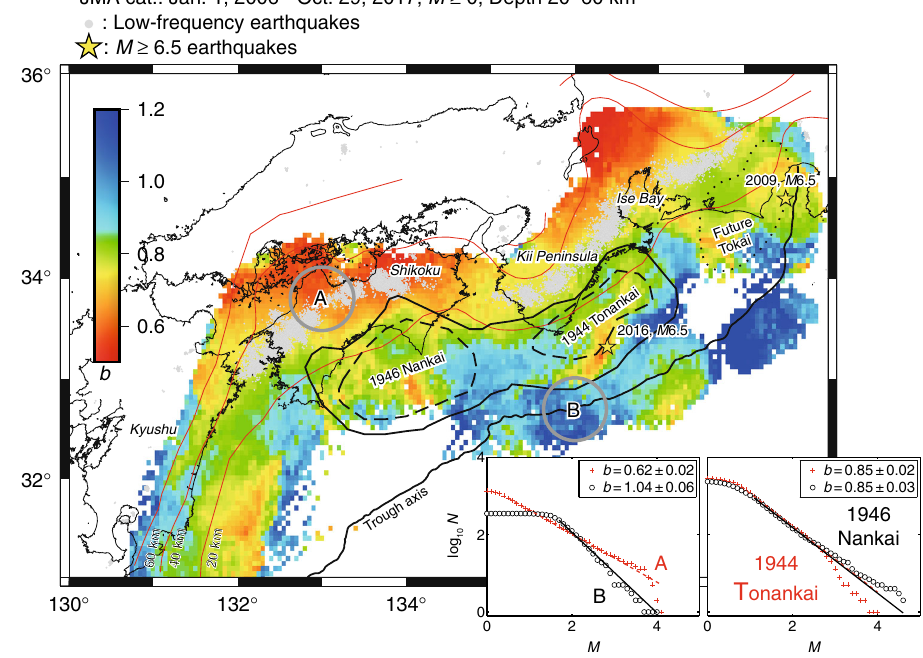
Fig. 1 Map of b values. Earthquake data used to create this b map are given at the top left of this fi gure (also see Data availability). The software package ZMAP 47 was used to create a dense spatial grid (0.05×0.05 degrees), to sample earthquakes that fell in overlapping volumes of circular shape with a radius of r = 35 km, and to map b values calculated by the EMR 46 technique. Dotted line delineates a region supposed to be sources of the anticipated Tokai earthquake 14 . Solid and dashed lines denote the regions of estimated large slips (>2 and 4 m, respectively) resulting from the 1946 Nankai and 1944 Tonankai earthquakes 12 . Grey dots show low-frequency earthquakes. Red curves mark depth contour lines 40 – 43 (also see Data availability). Inset: frequency – magnitude distribution for annotated regions with r = 35 km indicated by A and B and for the slip regions (>4